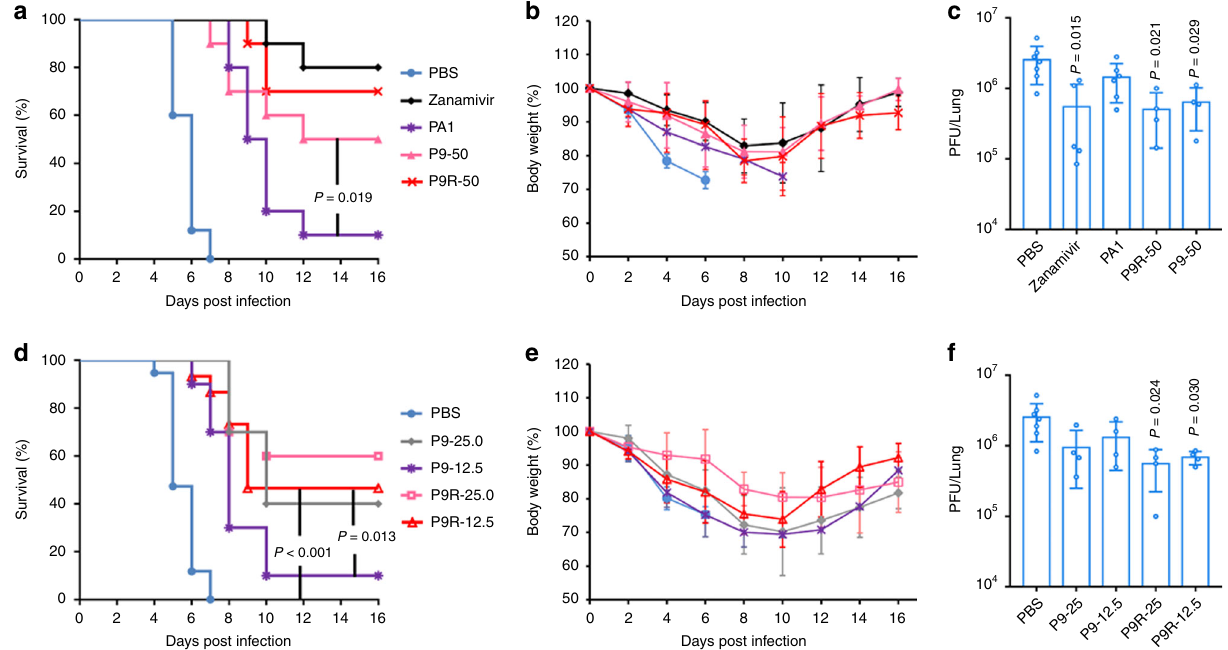
Fig. 4 The therapeutic protection of P9R on A(H1N1)-infected mice. a P9R (50 μ g/dose) could provide similar therapeutic ef fi cacy on mice infected by A (H1N1) virus as that of zanamivir (50 μ g/dose). PBS ( n = 10), zanamivir ( n = 10), PA1 ( n = 10), P9R (n = 10), or P9 (n = 10) were intranasally inoculated to mice at 6 h post infection and two more doses were administrated to mice in the following one day. P value was calculated by Gehan – Breslow – Wilcoxon test. b The body weight change of infected mice corresponding to a . c Viral loads in lung tissues corresponding to a . d Low doses of P9R could more ef fi ciently protect mice infected by A(H1N1)pdm09 virus than that of P9. PBS ( n = 20), P9-25 (25.0 μ g/dose, n = 10), P9-12.5 (12.5 μ g/dose, n = 10), P9R- 25 (25.0 μ g/dose, n = 10), and P9R-12.5 (12.5 μ g/dose, n = 15) were intranasally inoculated to mice at 6 h post infection and two more doses were administrated to mice in the following one day. P value was calculated by Gehan – Breslow – Wilcoxon test. e The body weight change of infected mice corresponding to d . f Viral loads in lung tissues corresponding to d . Ten to twenty mice in each group for survivals were included. P values of survivals were calculated by Gehan – Breslow-Wilcoxon test. For viral loads in mouse lungs, data are presented as mean ± SD from more than three mice in each group. P values of viral loads were calculated by the two-tailed Student ’ s t test when compared with mice treated by PBS. Source data are provided as a Source data fi